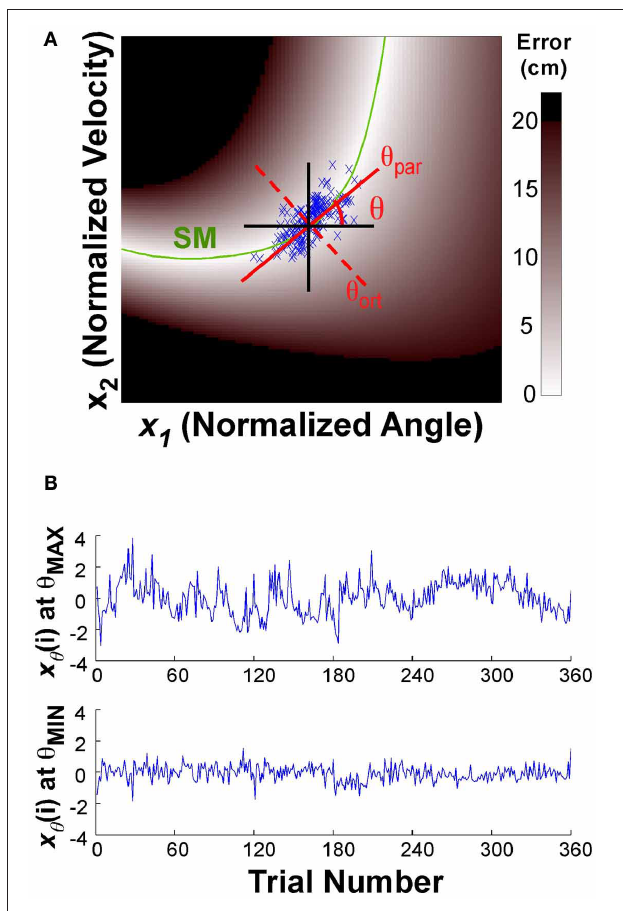
FIGURE 3 | (A) Execution space and illustration of the rotation axis used to analyze temporal fluctuations in different directions. The execution space was normalized by the individual subject’s standard deviations. The green line shows the solution manifold (SM); the black lines show the directions parallel to the x- and y-axes; the red lines show the rotation axes parallel to and orthogonal to the solution manifold, respectively. The one-dimensional time series x θ ( i ) is obtained by projecting the variables onto the rotation axis as expressed in the equation. (B) The time series at the top shows x θ ( i ) for the rotation angle θ with the maximum autocorrelation value, the bottom time series shows x θ ( i ) for the rotation angle θ with the smallest